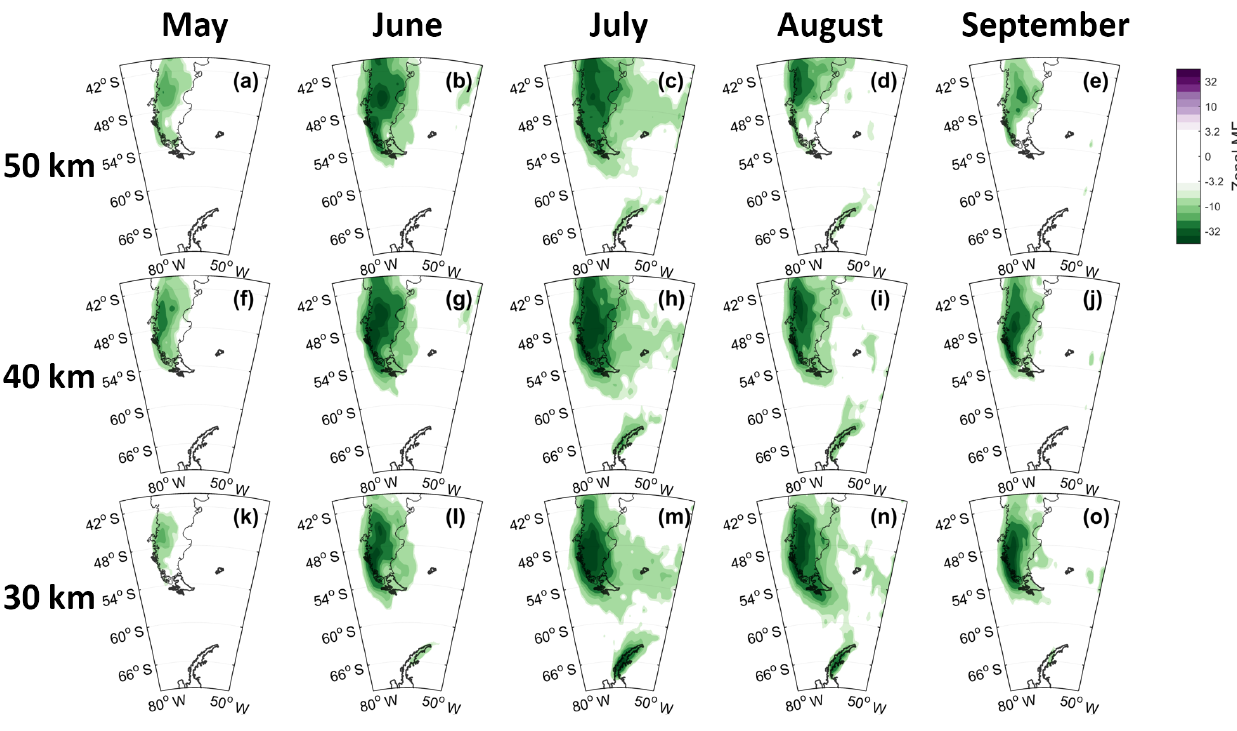
Figure 7. Zonal MF monthly means at three height